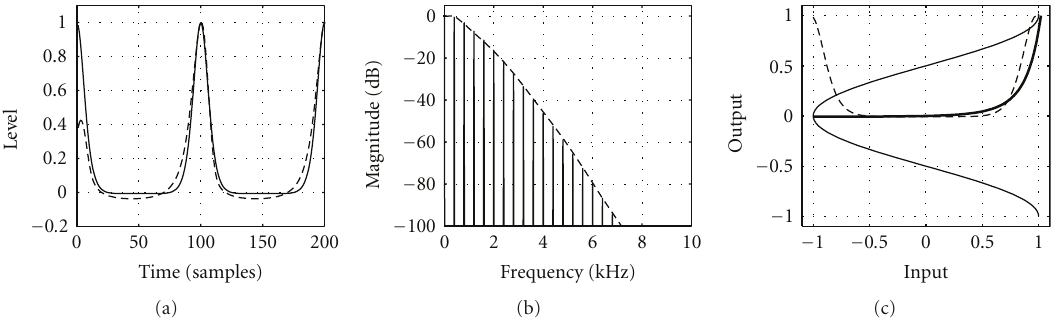
Figure 23: (a,b) Closed-form approximation ( a = 2 . 5, solid) of FBAM ( β = 1, dashed) and (c) its waveshaper formulation (input as thin, shaping function as thick, and output as dashed line).